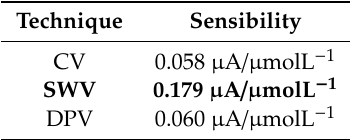
Table 5. Comparison between sensitivities obtained with the proposed sensor, aiming at the determination of Ethinyl estradiol, using di ff erent voltammetric